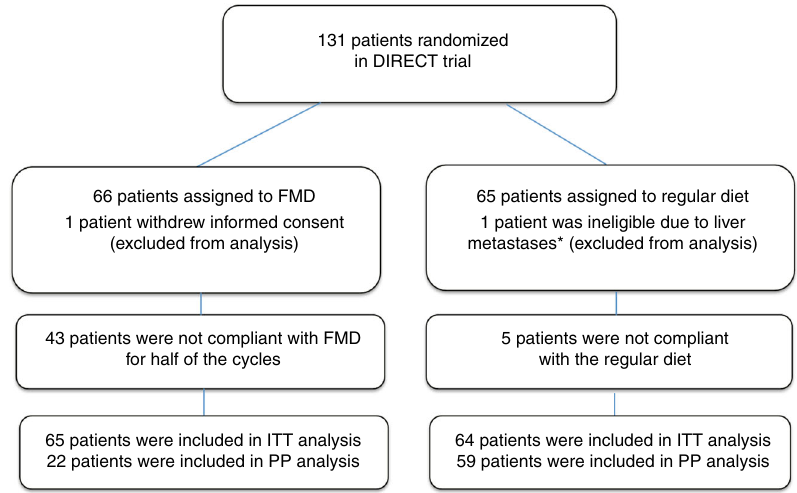
Fig. 1 Consort diagram of the DIRECT study. This fi gure shows reasons for exclusion from the study and the numbers of patients included in the PP and ITT analyses. Abbreviations: FMD: fasting mimicking diet, ITT: Intention to treat, PP: Per protocol. * diagnosed the day after